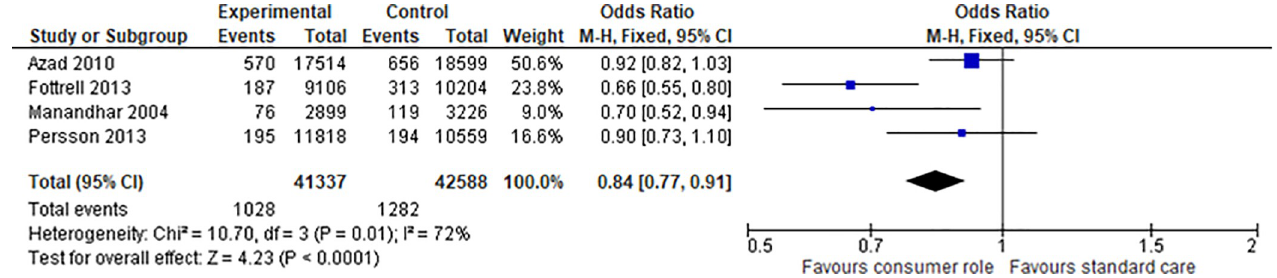
PLOS ONE | https://doi.org/10.1371/journal.pone.0261808 January 27,